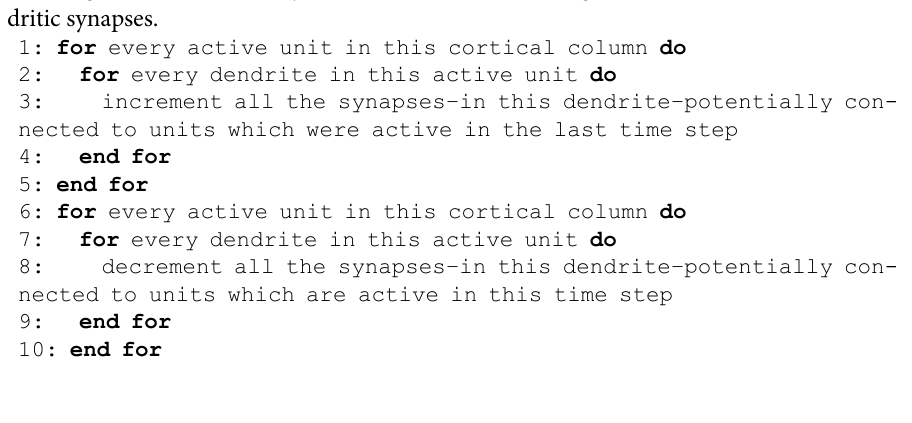
homeostatic regulation plasticity in the synaptic strength regulation in distal dendritic branches. Algorithm 2 Plasticity in Distal Synapses . This algorithm accounts for Spi- ketiming dependent plasticity (STDP) and homeostatic regulation phenomenon in distal den- dritic synapses.